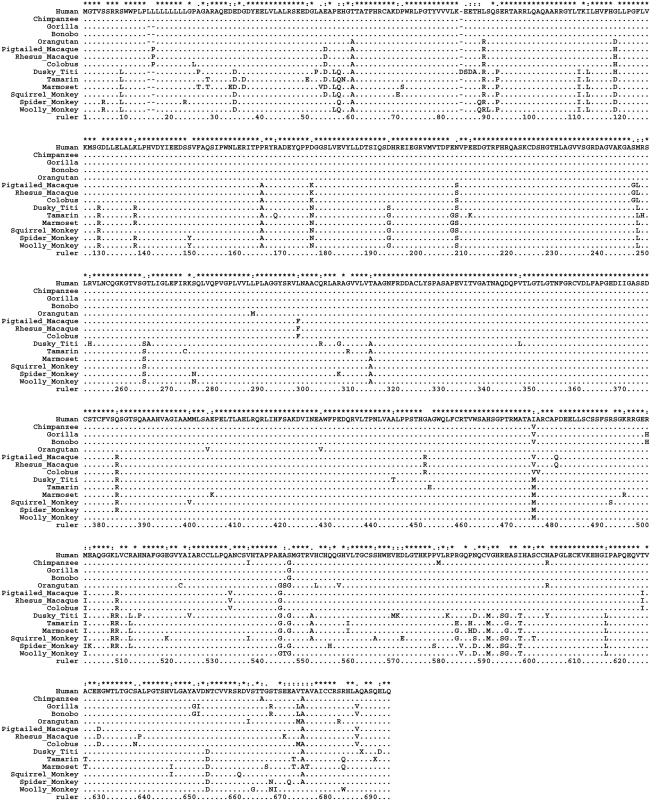
Protein sequence alignment of PCSK9 in 14 primates.“.” Indicates identity to the first sequence (i.e., human) in each alignment. “-” indicates an alignment gap, and “X” indicates a stop codon. The coordinates after 84 should be minus one to be consistent with that in Human reference sequence (NP_777596), since an insertion at position 84 was present in the dusky titi. The signal peptide (SP) domain (1–90) shows the evolution of Leucine (Leu) repeats (15–23) in PCSK9, and the C-terminal domain shows the premature stop codon (X) in the tamarin (686), and dusky titi (689).